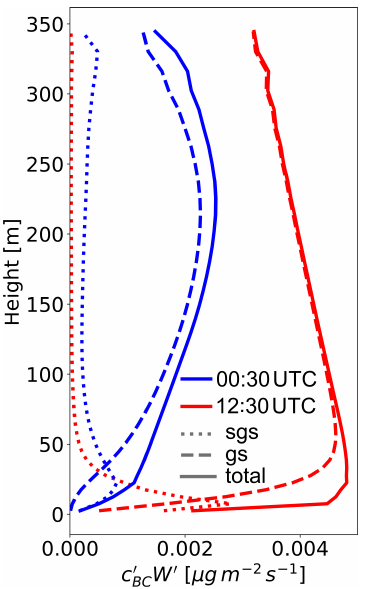
Figure 14. Vertical mixing of scalar BC within the PBL as simu- lated with CAIRDIO L0 on 2 March at 00:30UTC featuring a stably stratified PBL (blue lines) and on 2 March at 12:30UTC featuring a convective PBL (red lines). Dashed lines show grid-scale mixing, dotted lines the sgs contribution, and full lines total mixing consist- ing of grid-scale plus sgs